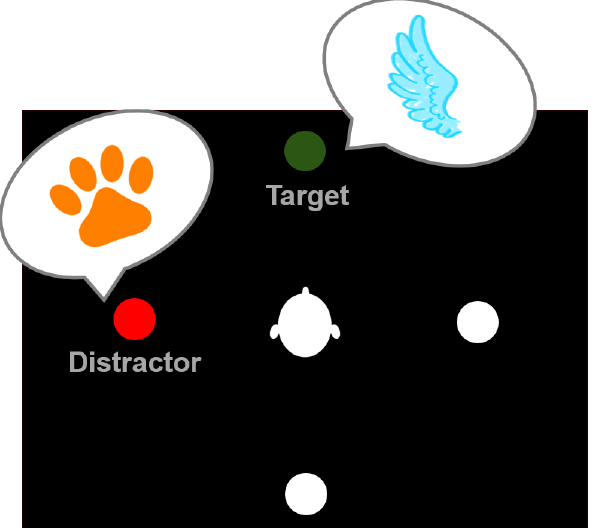
Figure 4. Exemplary trial indicating the target stimulus at the frontal and the distractor at the left position. The target stimulus belongs to the category of flying animals, while the distractor is a non-flying animal, yielding an incongruent trial.